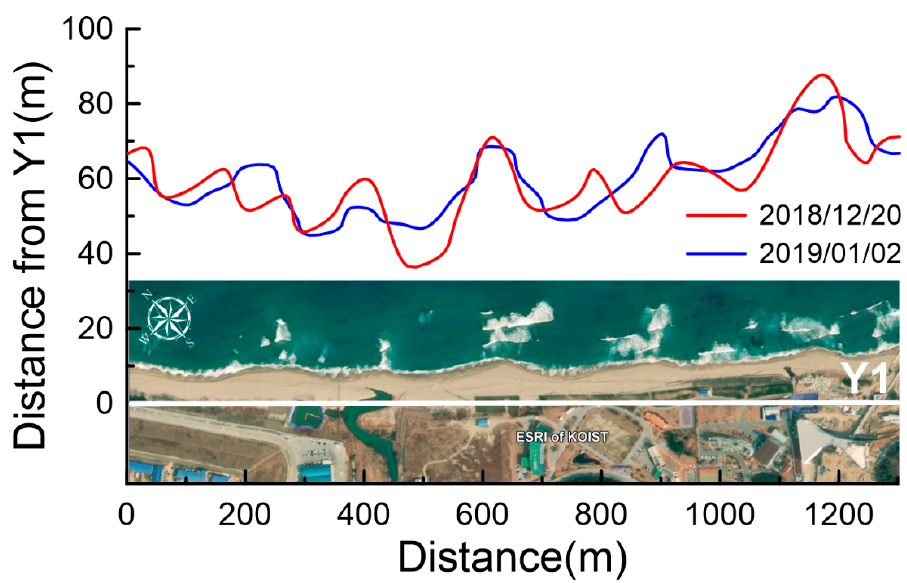
Figure 8. Comparison of shoreline positions in Hujeong Beach measured by VMS between 20 December 2018, 2 January 2019 for Exp#2. The google map shows the corresponding locations of the retreat/accretion areas along the beach.